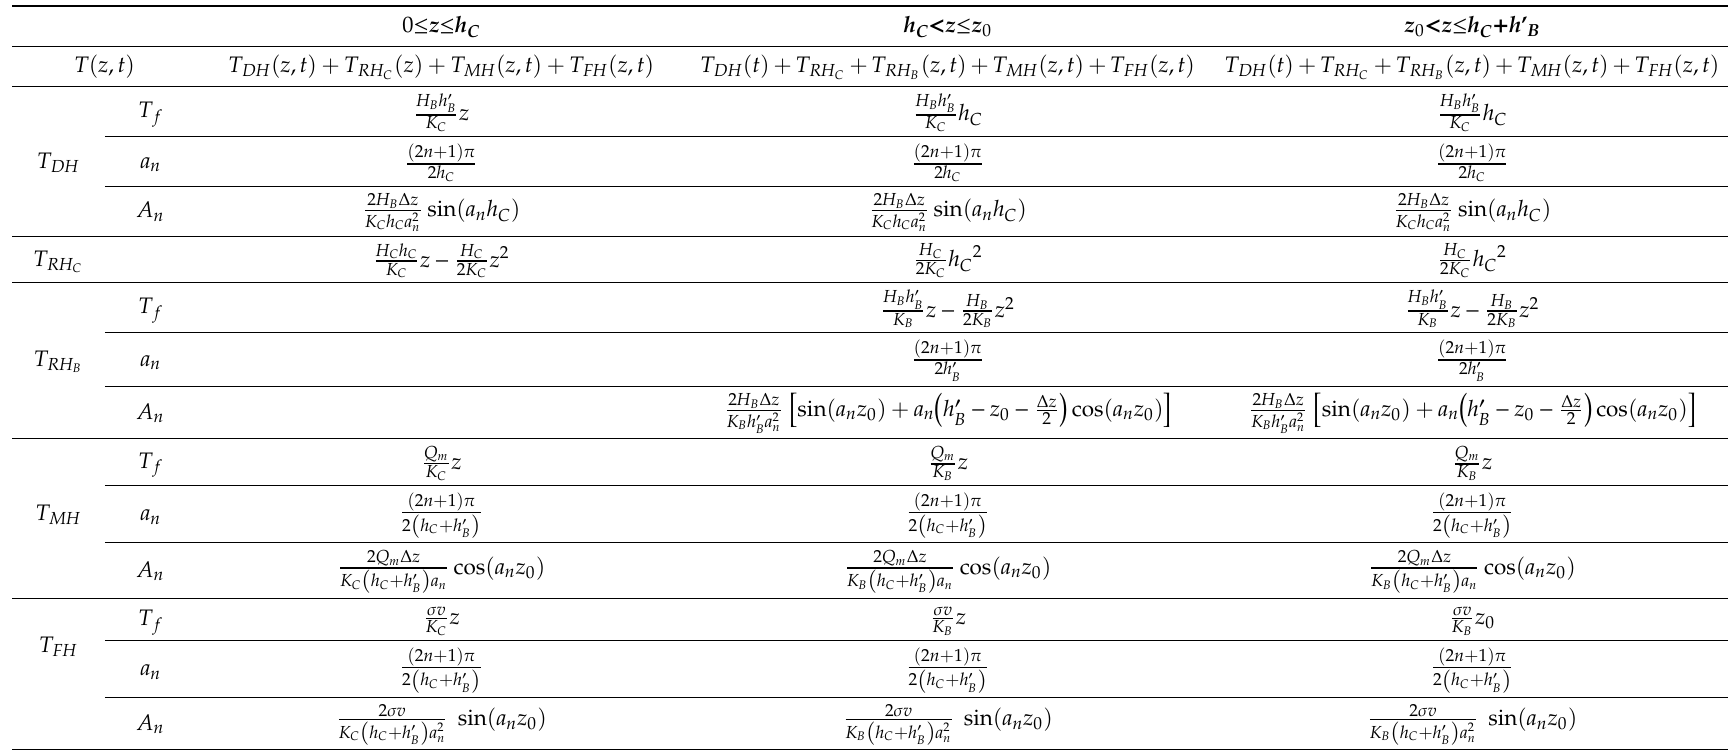
Table 1. Terms of the equations used for the analytical